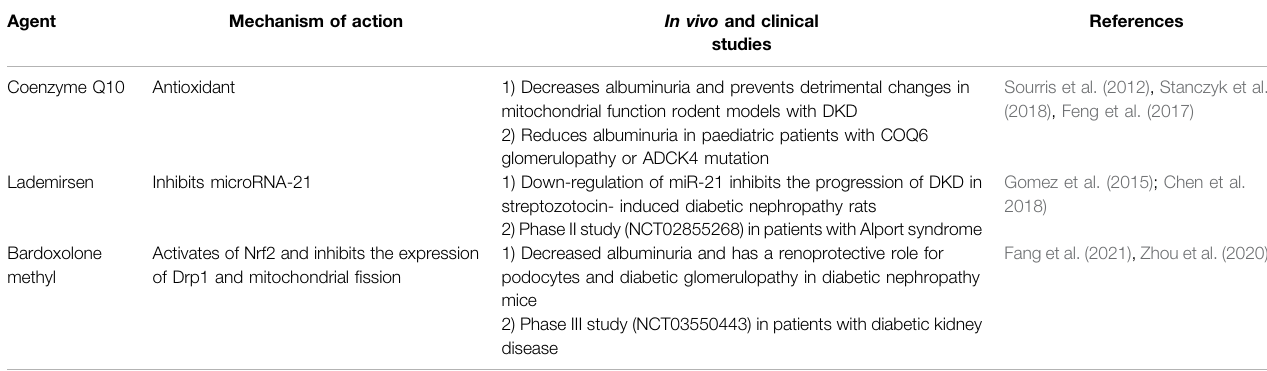
TABLE 1 | Potential approaches to target podocyte mitochondrial dysfunction in clinical